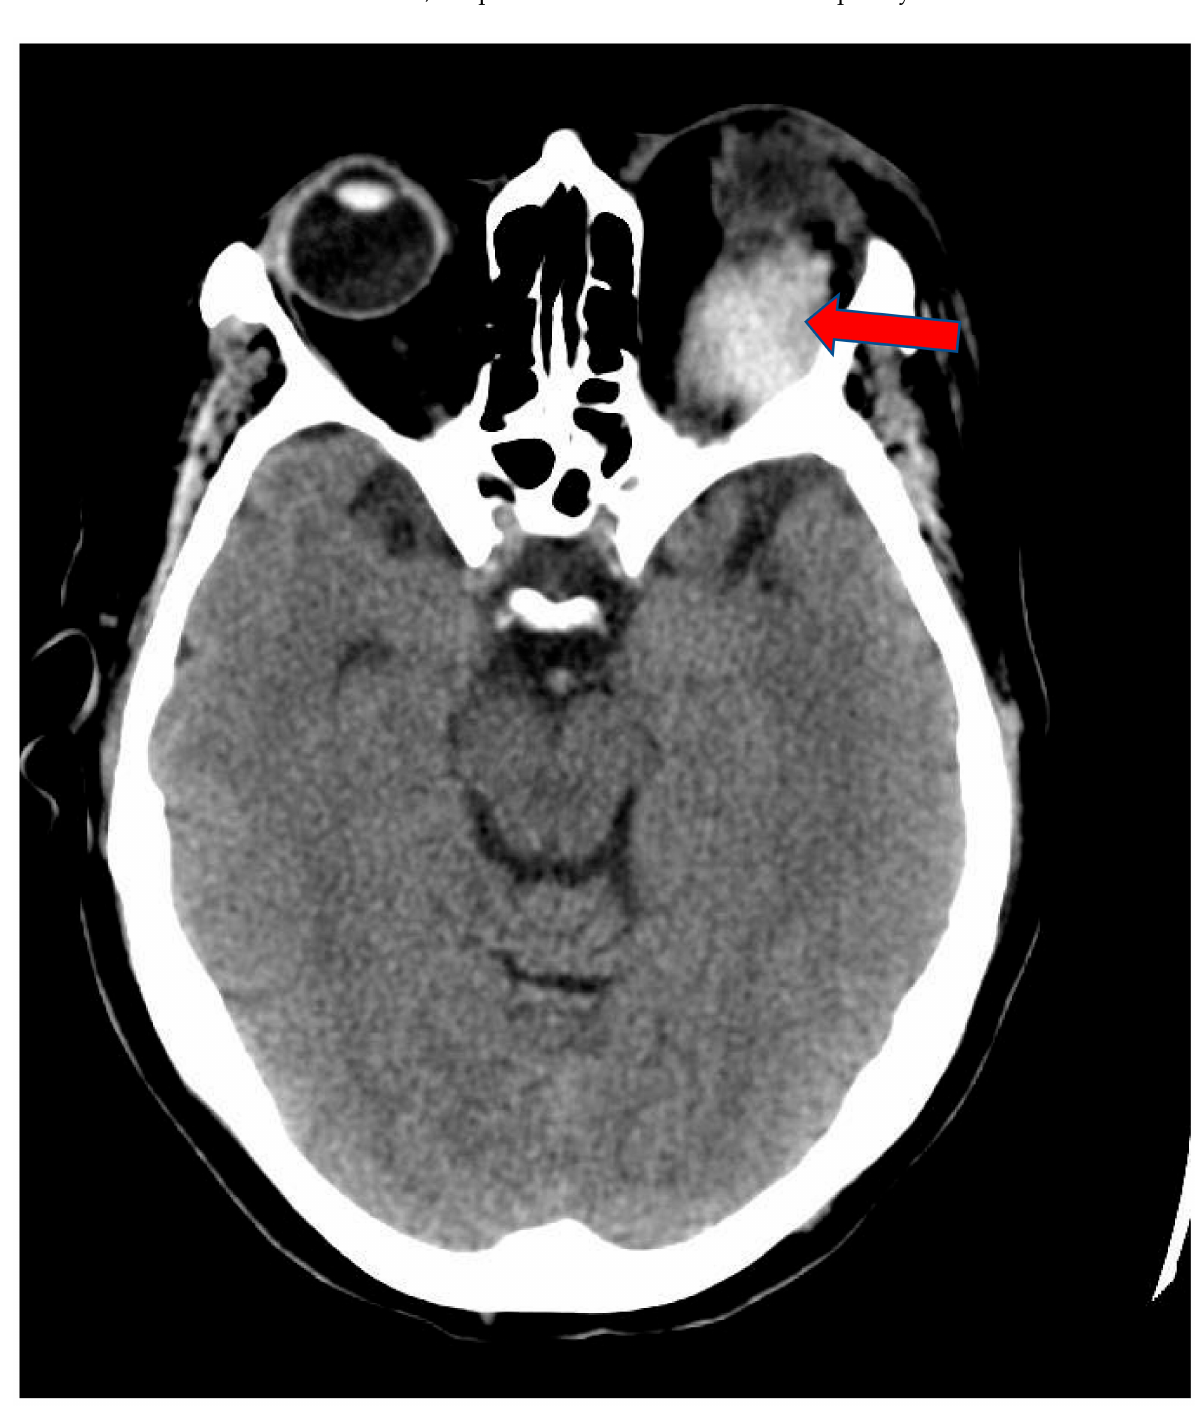
Figure 1. Axial view of Brain CT scan showing left periorbital soft tissue swelling with hyper dense mass. This appears to be located above the superior rectus muscle